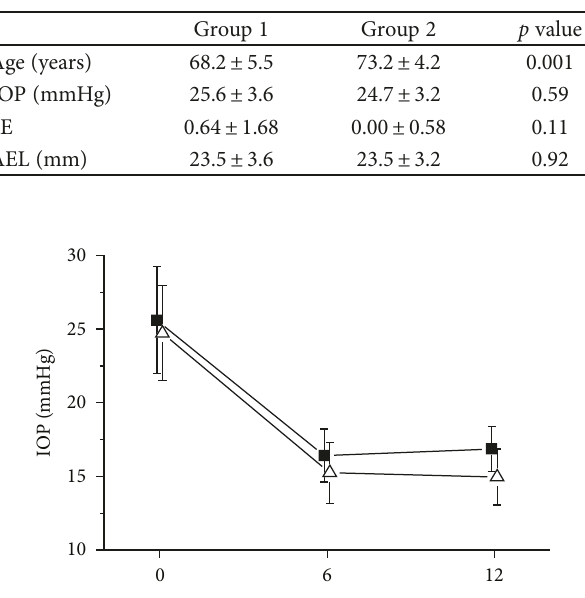
Table 1: Demographic and clinical patient data.